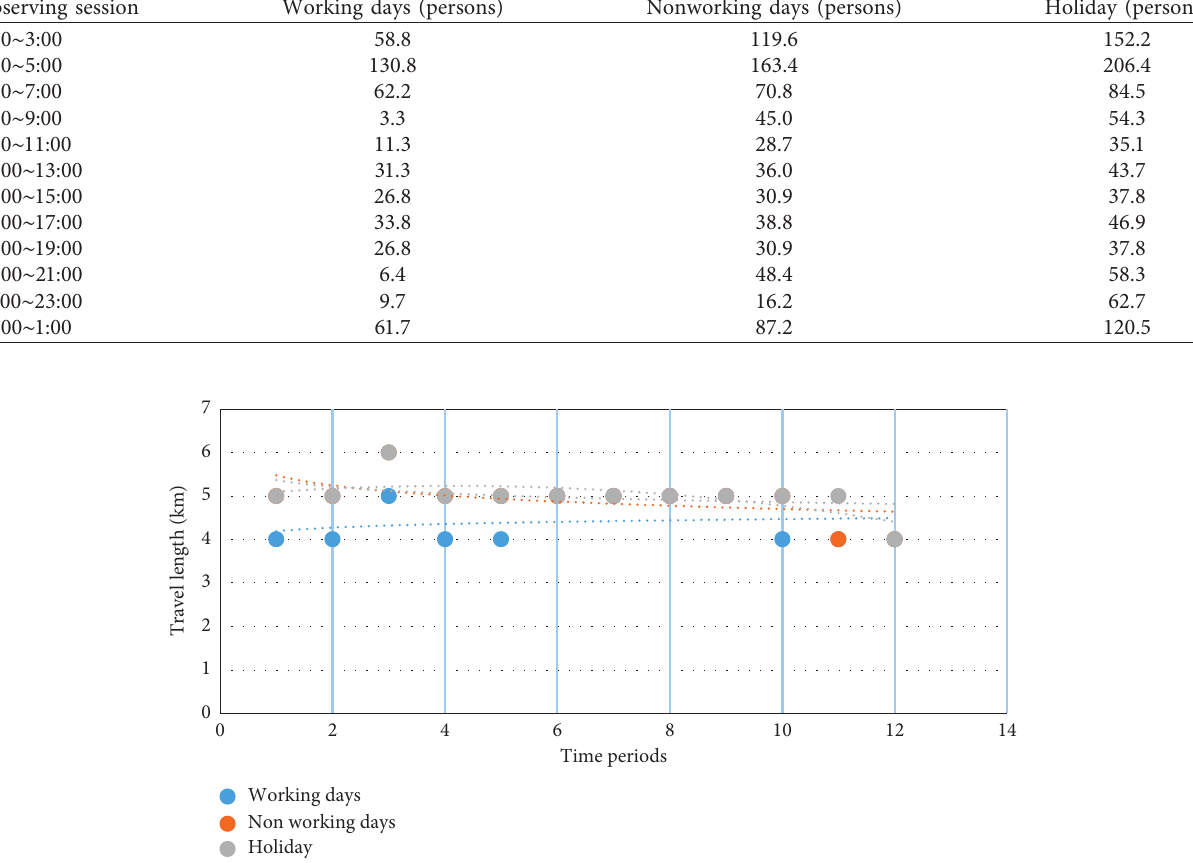
Table 12: Driver selection decision scheme in different periods.